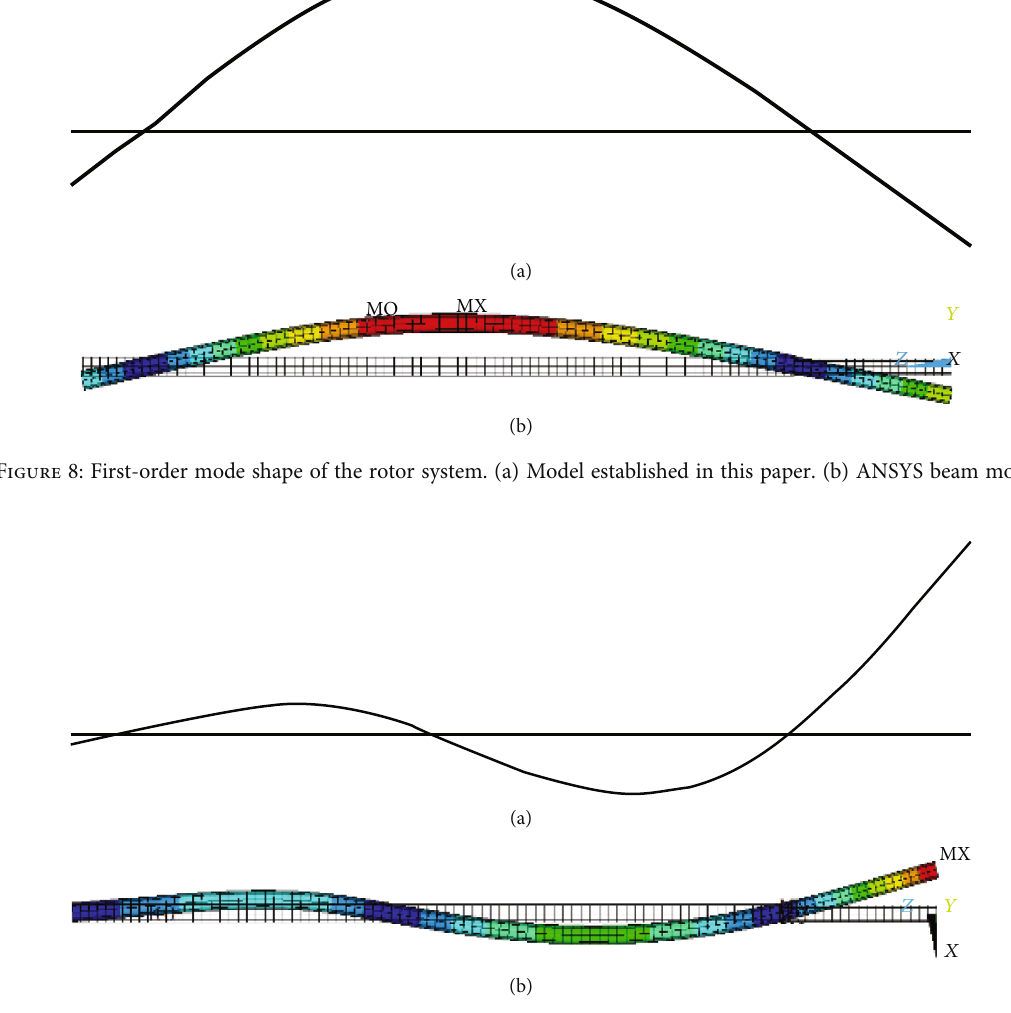
Figure 9: Second-order mode shape of the rotor system. (a) Model established in this paper. (b) ANSYS beam